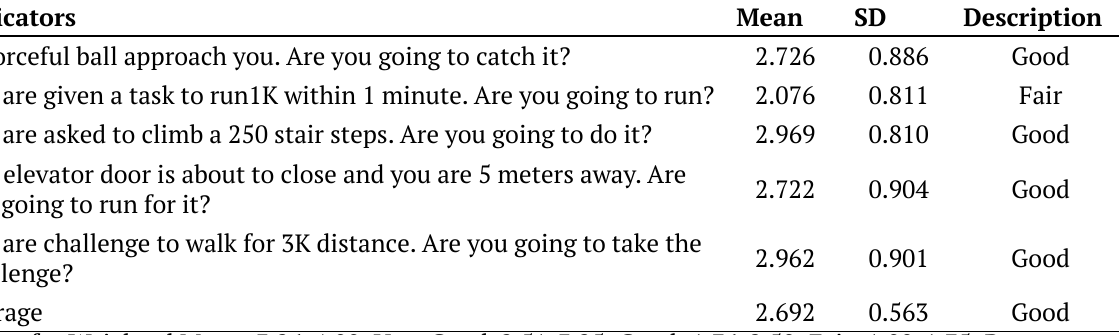
Table 4. Perceived Ascaled affordance measures of students